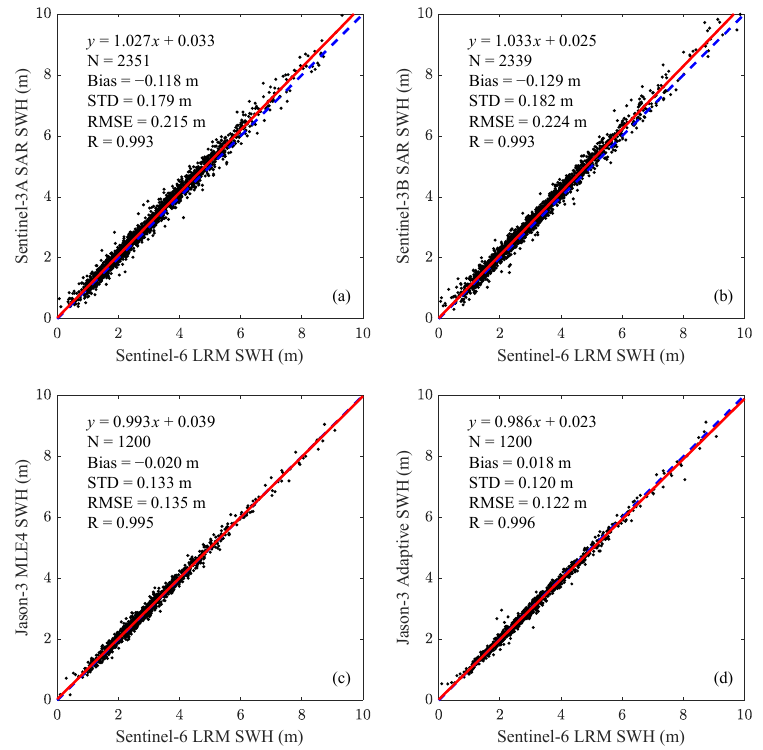
Figure 14. Scatterplots of Sentinel-6 SWH measurements in LRM against ( a ) Sentinel-3A SARM, ( b ) Sentinel-3B SARM, ( c ) Jason-3 MLE-4 and ( d ) Jason-3 adaptive re-tracking measurements.